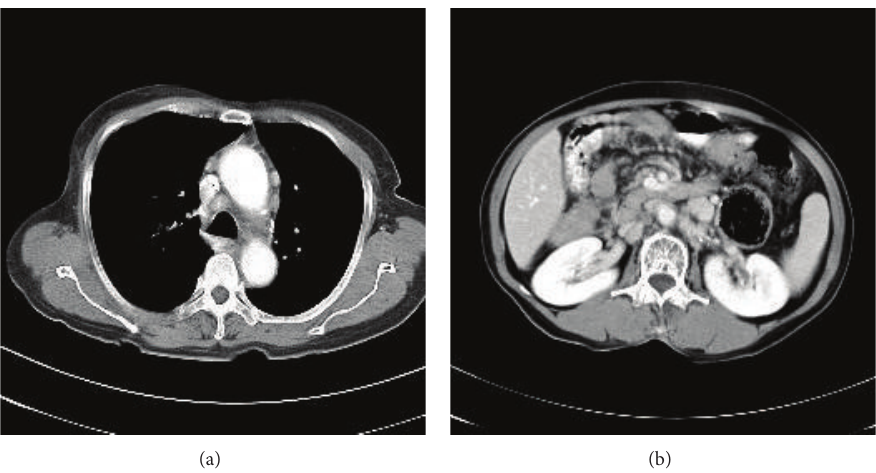
Figure 3: (a) A follow-up chest CT after 3 cycles of ABVD chemotherapy shows dramatic improvement of the lymphadenopathy in the mediastinum. (b) As compared with previous APCT, enlarged lymph nodes are decreased in number and size after 3 cycles of ABVD chemotherapy.